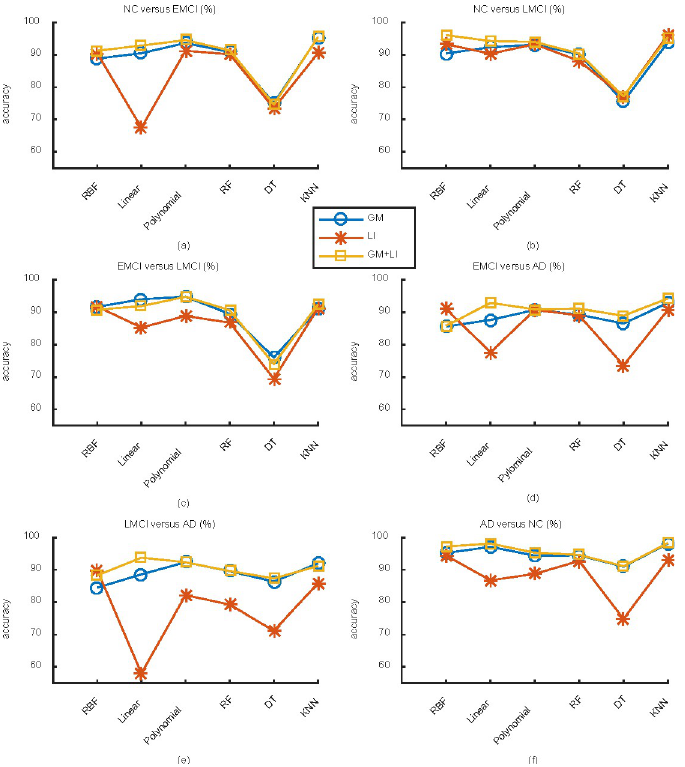
Fig 3. For each subject group, the classification accuracy under SVM classifier with RBF kernel, linear kernel and polynomial kernel, RF classifier, DT classifier and KNN classifier.